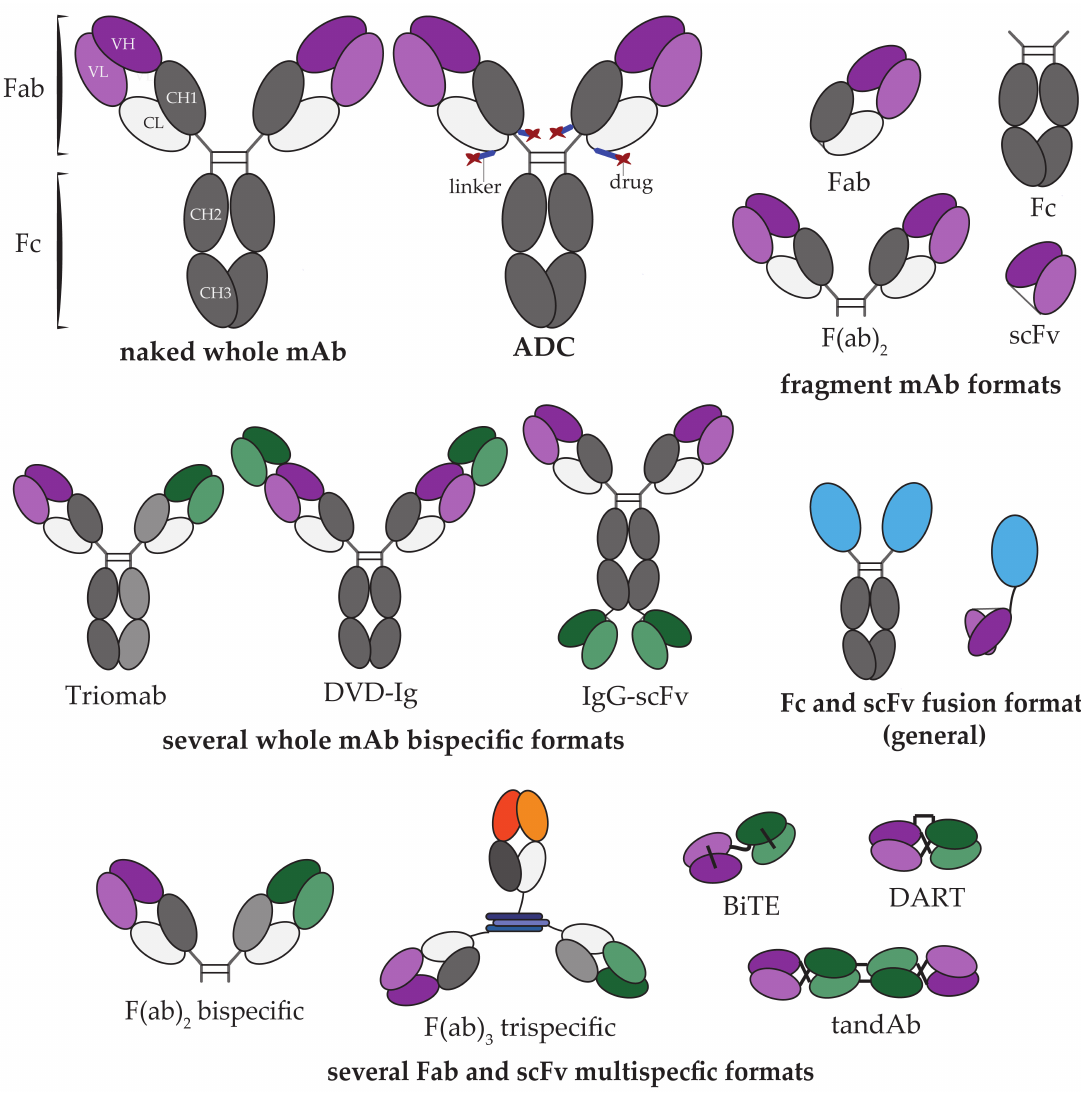
Figure 2. Schematic representation of a whole monoclonal antibody (mAb), a fragment mAb, and prominent fusion mAb formats that have been developed for strategic therapeutic uses. Proteins fused to mAb fragments are depicted as blue ovals for a general representation; however, fusion proteins may vary in size and structure. Fragment formats include the crystallizable (Fc), antigen binding (Fab and F(ab)2), and single-chain variable (scFv) fragments. Further whole mAb formats include the antibody–drug conjugate (ADC), triomab, dual variable domain immunoglobulin (DVD-Ig), and immunoglobulin–scFv fusion (IgG-scFv). Multispecific fragment formats include the F(ab)2 bispecific, bispecific T-cell engager (BiTE), dual a ffi nity re-targeting molecule (DART), and tandem diabody